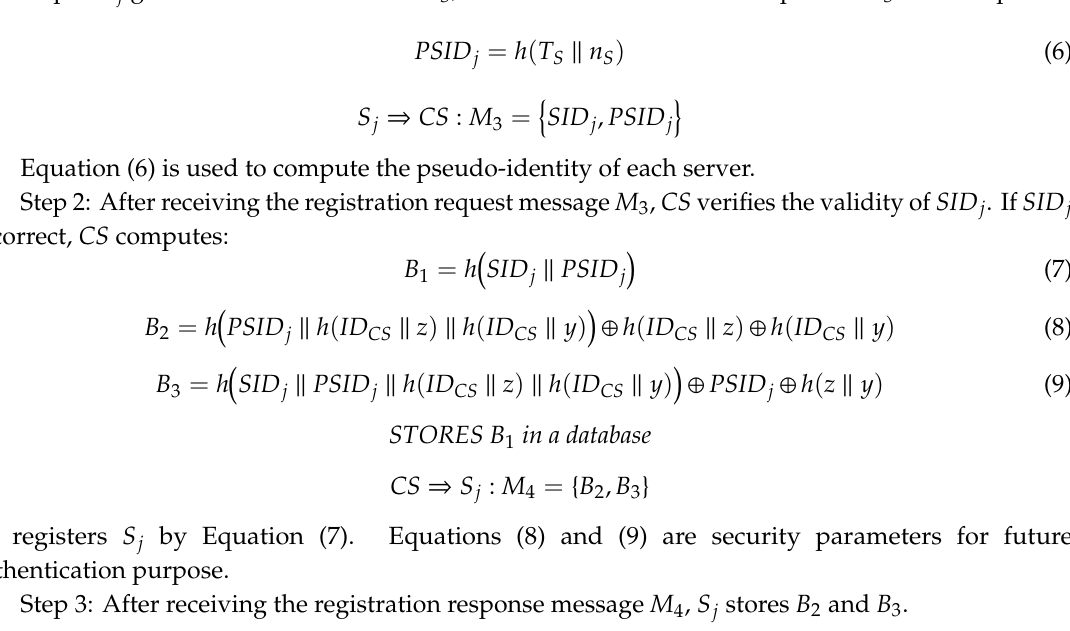
Figure 4. Login phase.